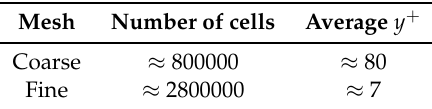
Table 3. Mesh cell count and average y +